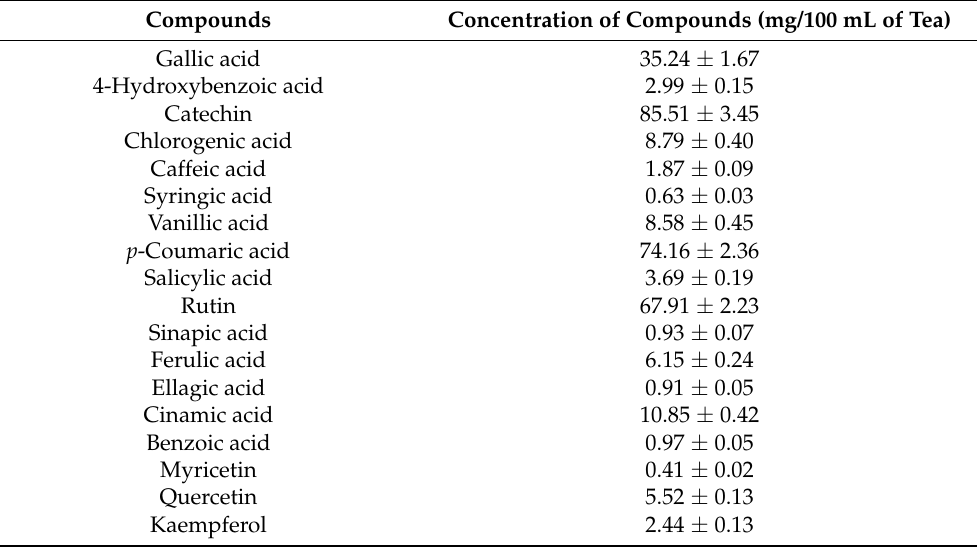
Table 2. Contents of phenolic acids and flavonoids identified from star anise tea by Rp-HPLC.